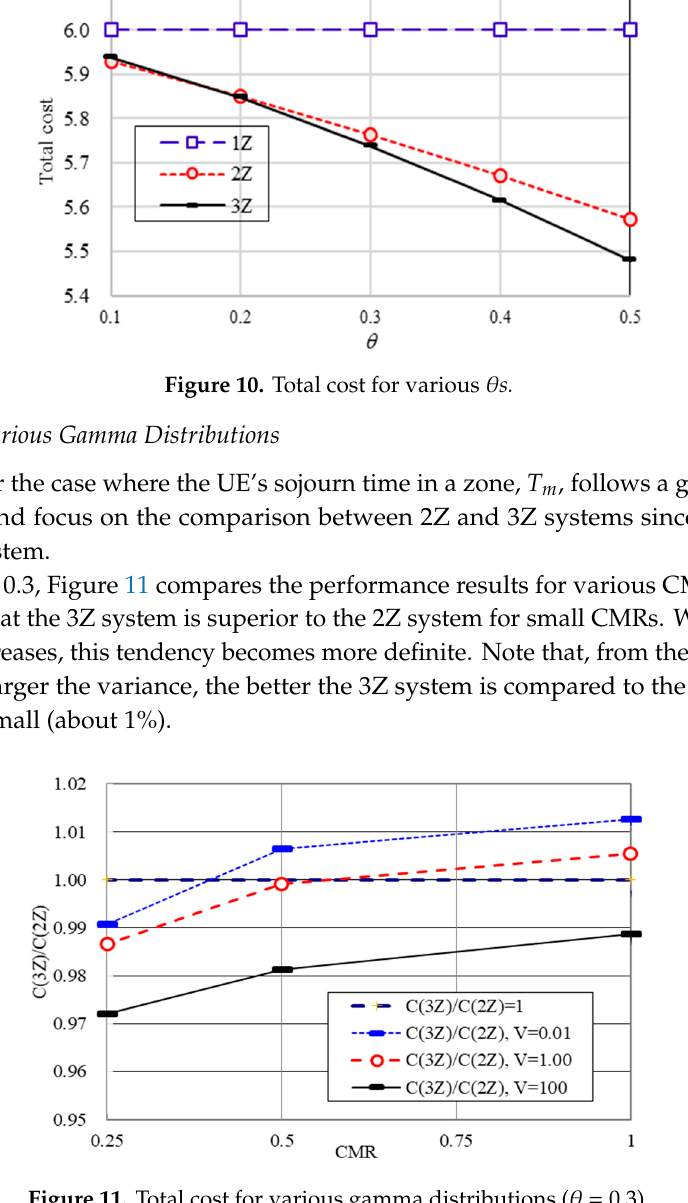
Figure 9. Total cost for various CMR.